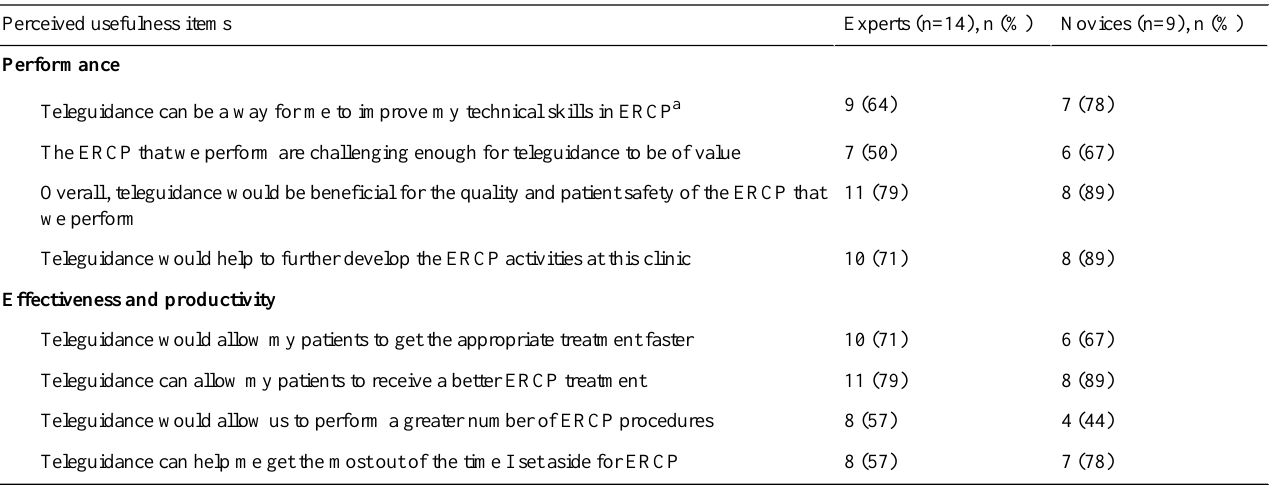
Table 1. Dichotomized agreement scores of perceived usefulness by experts and novices in endoscopic retrograde